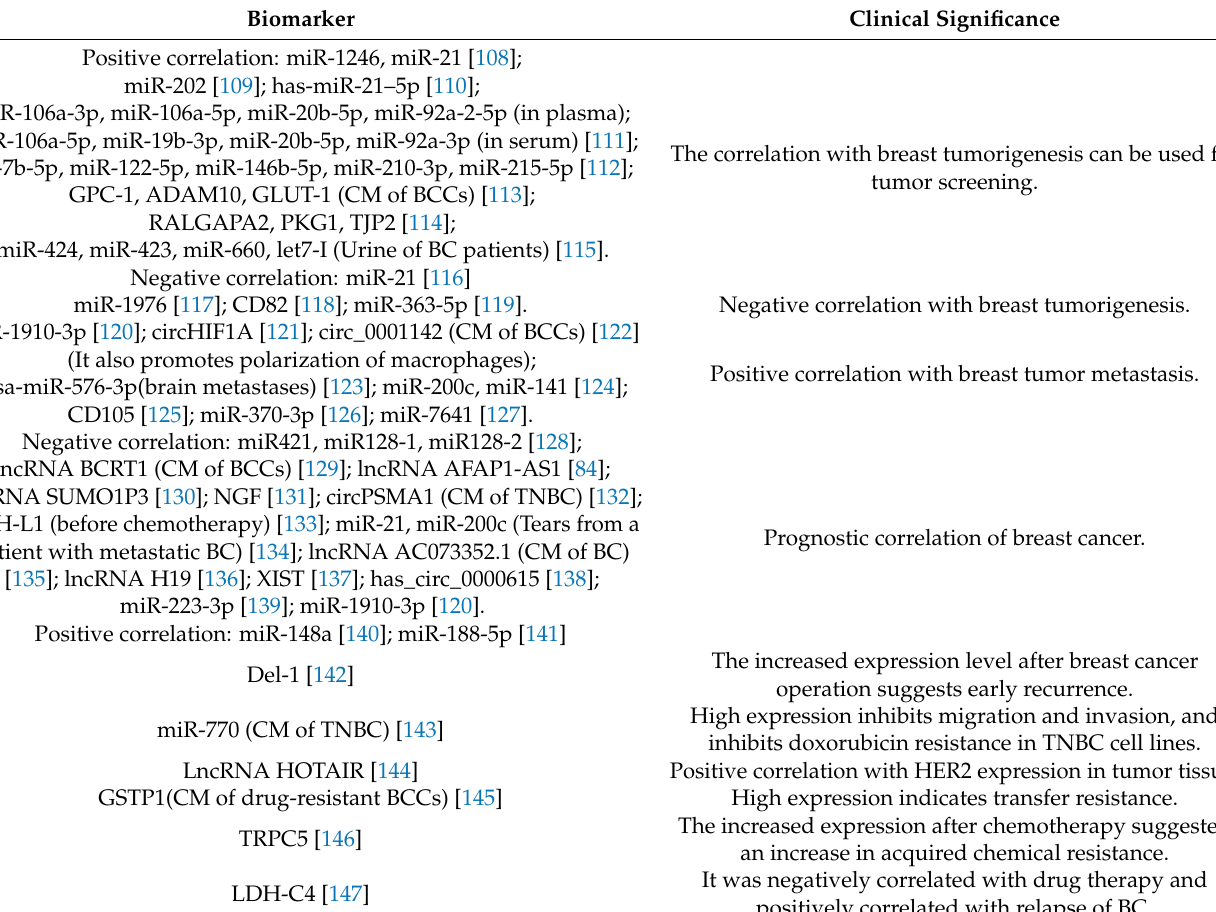
Table 1. Breastcancerbiopredictors. (Theunlabeled biomarkers were allbloodfrombreastcancer patients). Biomarker Clinical